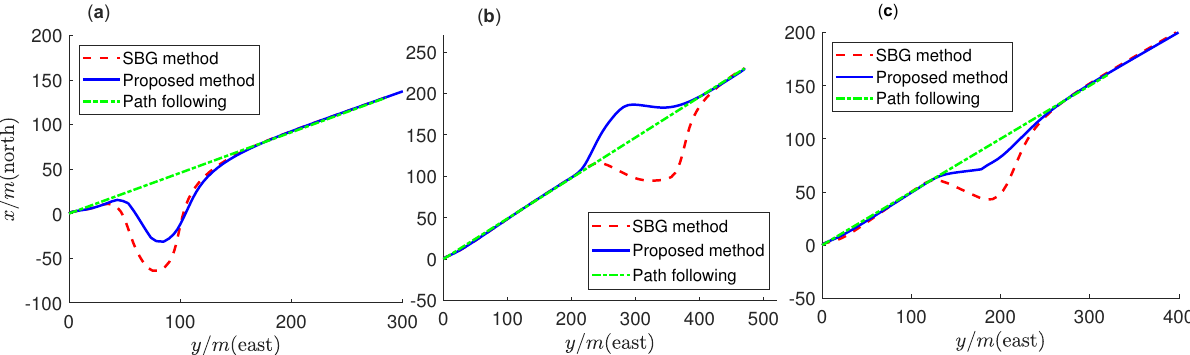
Figure 12. Comparison of the avoidance path trajectory for different encounter situations ( a ) crossing; ( b ) overtaking; ( c ) head −